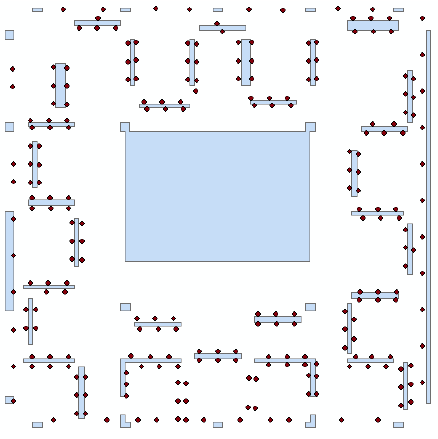
Figure 4. 2D Floor plan and artwork locations